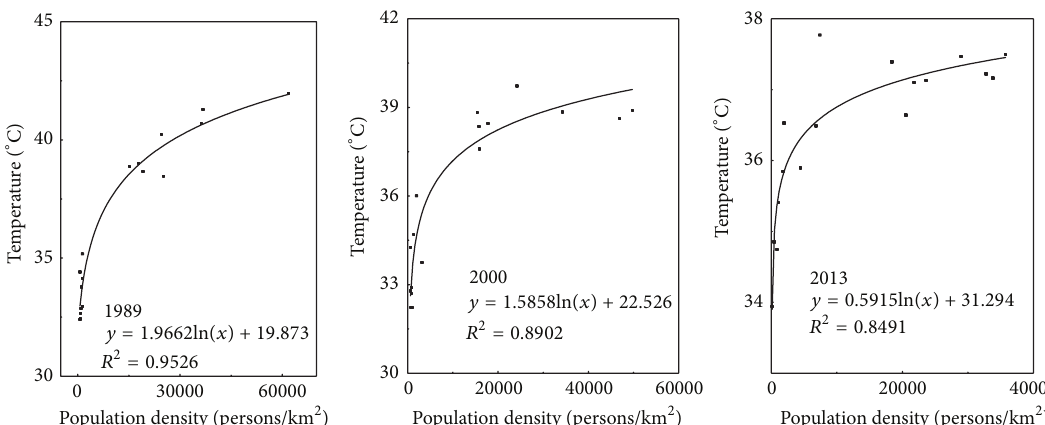
Figure 9: Correlation between LST and population density ( 𝑥 : population density; 𝑦 : mean LST).